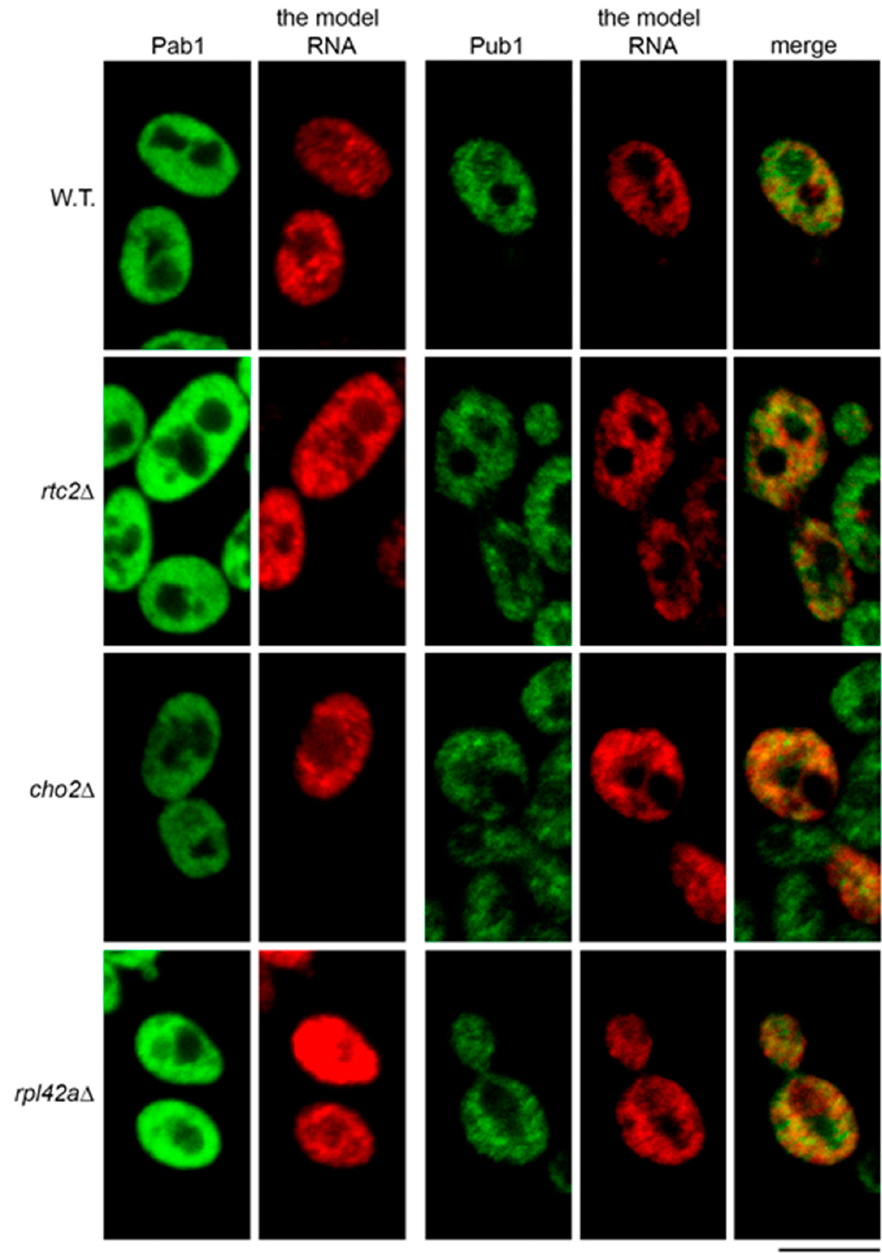
Figure 6. Accumulation of the model RNA in the mutants is not linked to its targeting to stress granules. FISH-IF of the model RNA (expressed as in Figure 2) and stress granule markers Pab1 (left panel) and Pub1 (right panel) in wild-type (BY4741, W.T.) and mutant strains as indicated on the left. Scale bar is 5 µm.